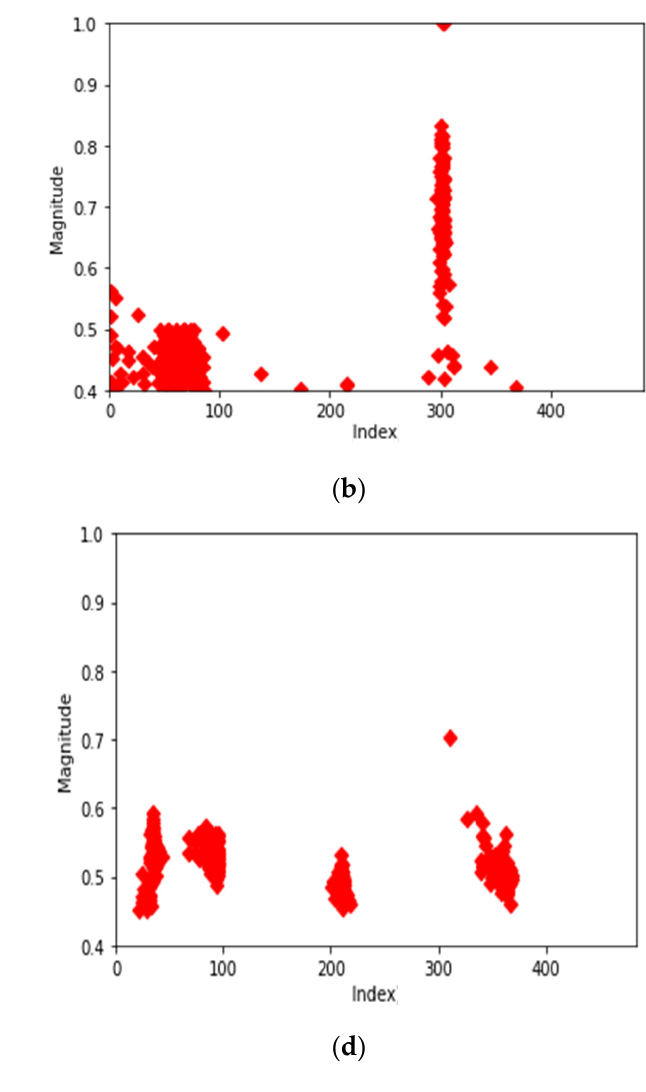
Figure 4. Cluster center points of normal data set and error data sets. ( a ) Center points of normal data (100 sets), ( b ) center points of first-order error data (100 sets), ( c ) center points of second-order error data (100 sets), and ( d ) center points of third-order error data (100 sets).